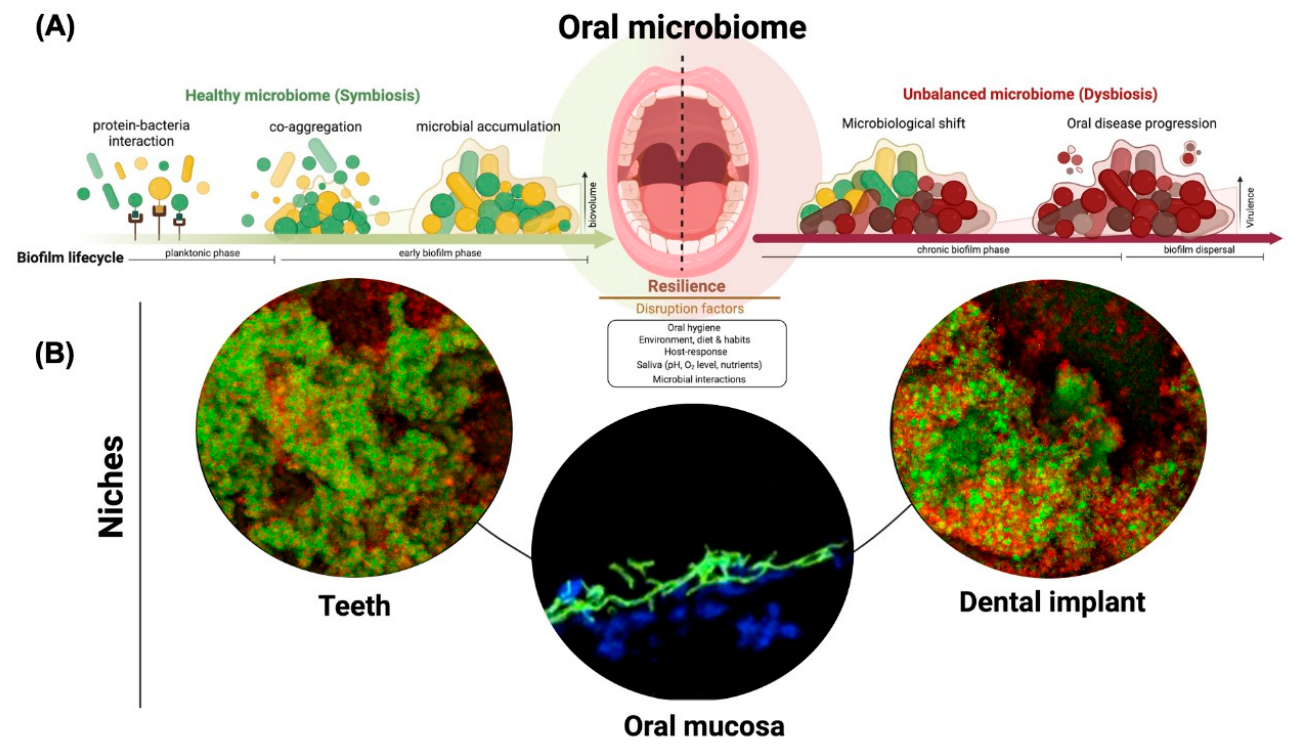
Figure 1. The biofilm formation in the oral cavity. ( A ) Oral surfaces (tooth and mucosal tissues) and any material (i.e., dental implant) inserted in the mouth act as a substrate for microbial adhesion and accumulation. Proteins immediately coat the surfaces from oral fluids (i.e., saliva and plasma), which is the main mediator of microbial adhesion through adhesin-receptor interactions. Then, initial colonizers adhere to the surfaces, binding to the protein layer, followed by co-aggregation processes and interaction between different species to promote biofilm accumulation. Different factors have been identified to disrupt the symbiotic state, leading to the overgrowth of putative pathogens (dysbiosis) able to trigger/foster oral diseases. ( B ) Polymicrobial biofilms can accumulate and induce oral diseases in different habitats of the oral environment, such as teeth, oral mucosa, and dental implants, as shown by microscopic confocal images (bottom) (created using Bio-Render ® ).